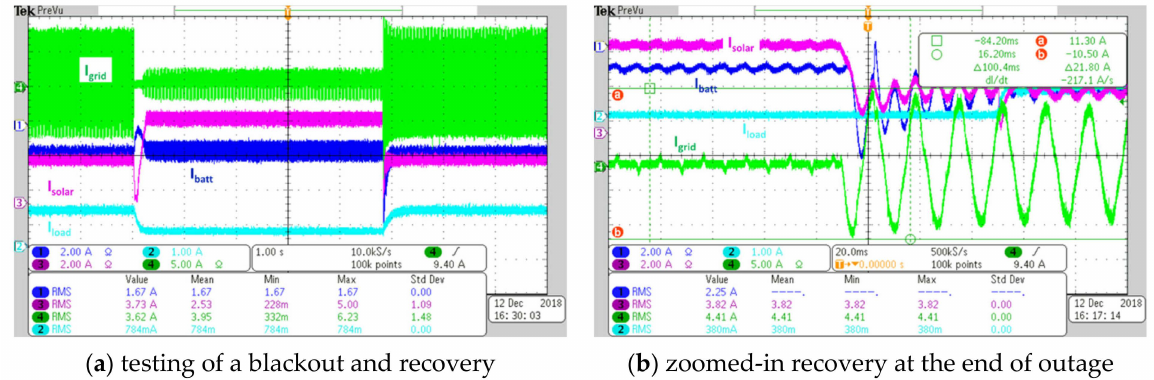
Figure 9. Stable performance of the MPEI with Q-learning-based